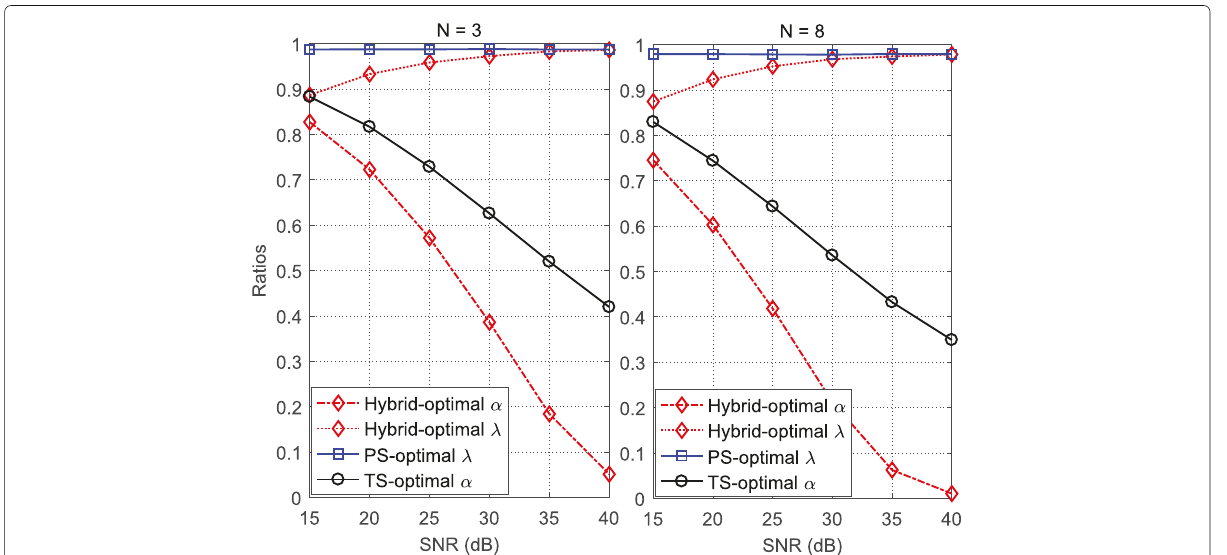
Fig. 10 Optimal α and λ under different protocols versus transmit SNR, d SR = 2 m